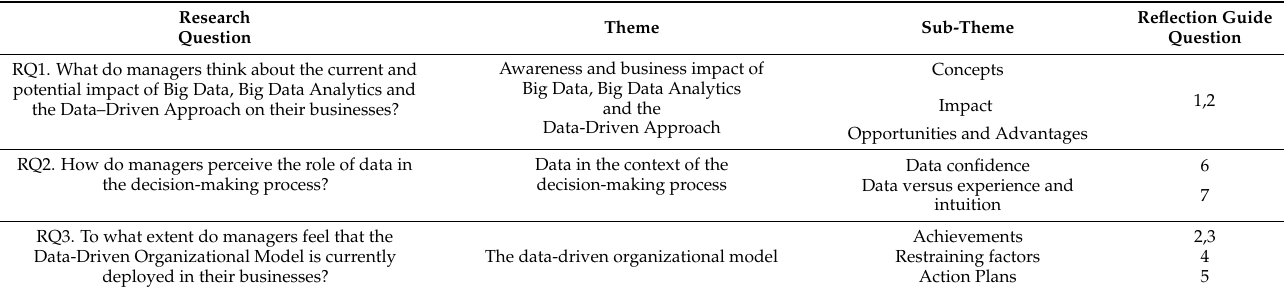
Table 1. Research framework-Topics